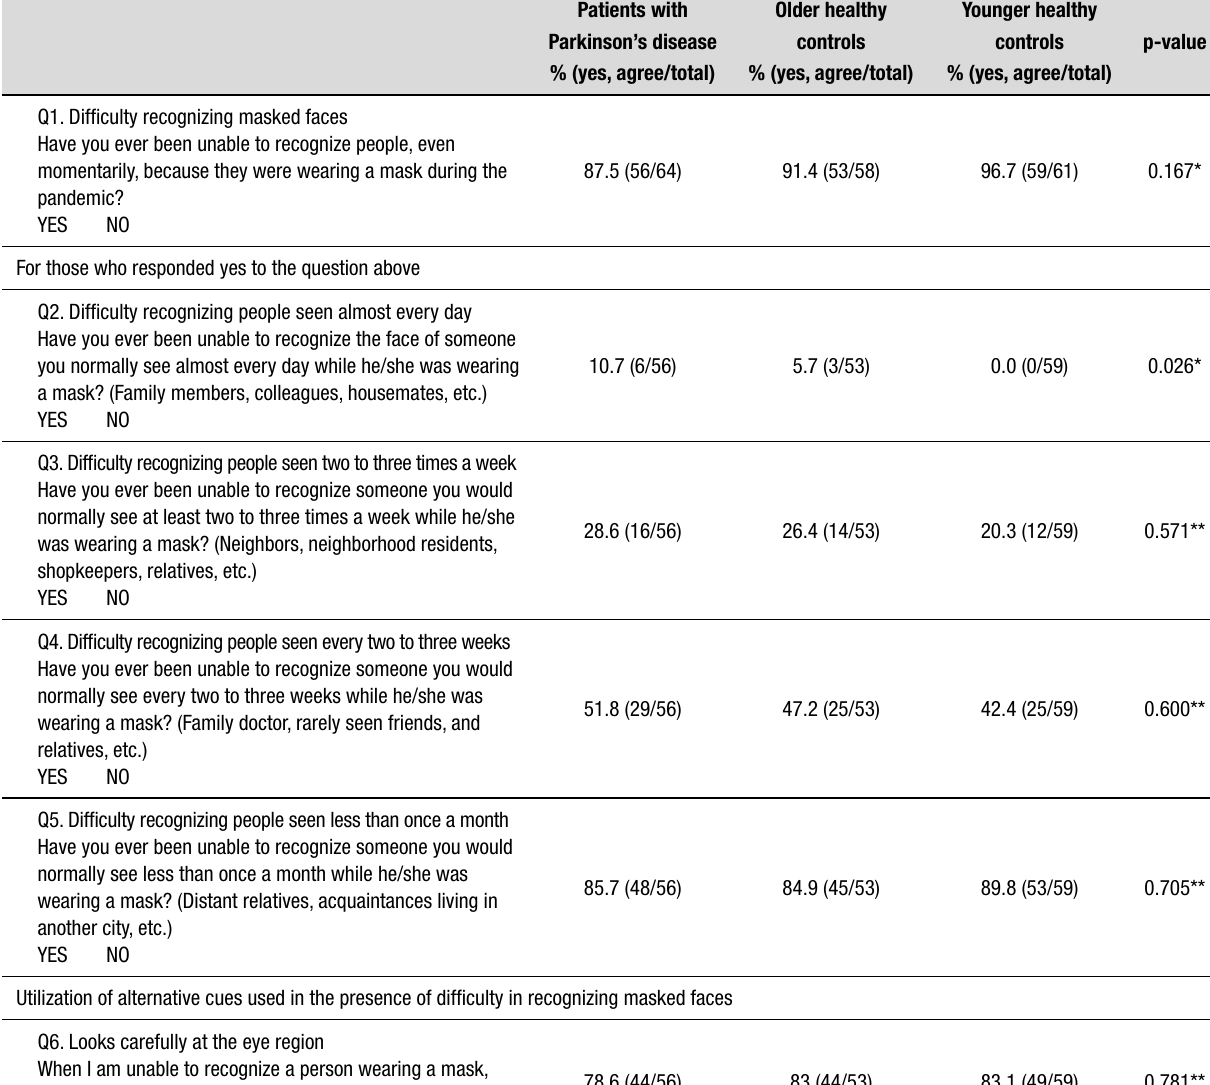
Table 1. Face recognition difficulties due to mask use during the pandemic questionnaire and analysis of responses.